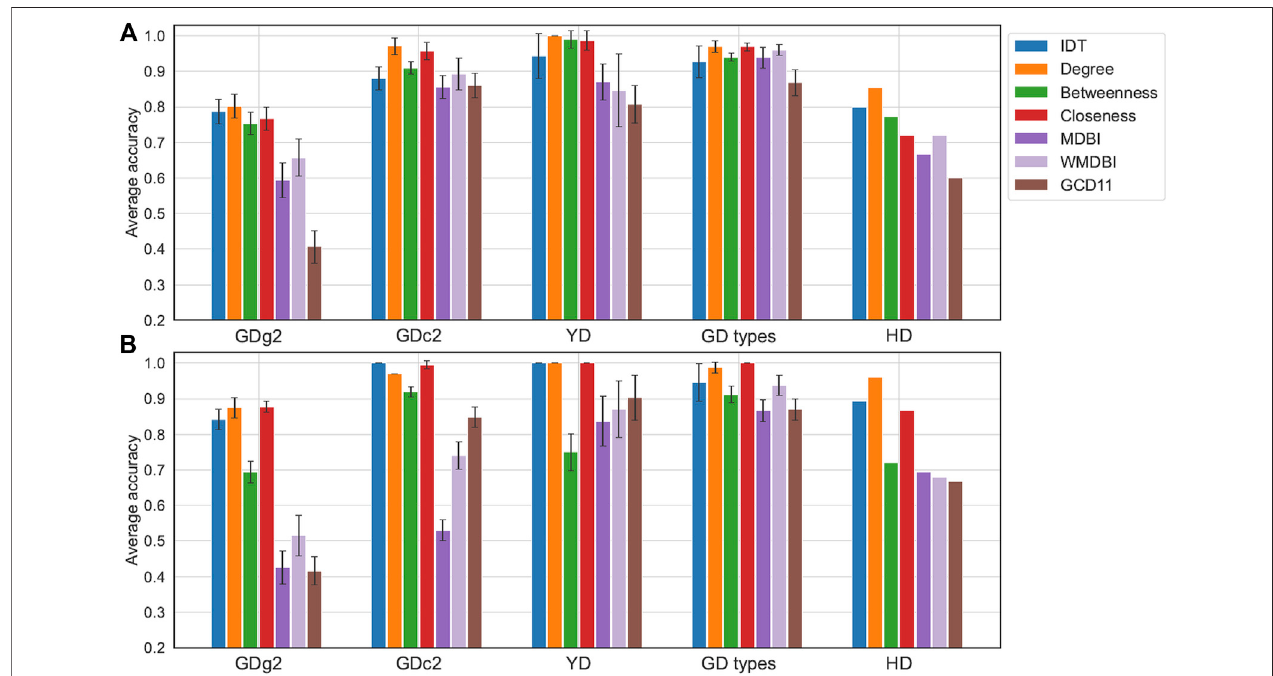
FIGURE 4 | Classi fi cation performance of models developed from IDT-treated data or sMDiN graph property methods. (A) Performance of random forest (RF) models; (B) performanceofprojectioninlatentstructures – discriminantanalysis(PLS-DA).Foralldatasetsexcept HD ,accuracywasestimatedby20iterationsofinternal three- or fi vefold strati fi ed cross-validation, with the error bars representing the accuracy standard deviation. For the HD dataset, accuracy was estimated on a test set resulting from a strati fi ed random 70/30% train/test split. Methods are as follows: intensity-based data pretreatment (IDT); network analysis: degree analysis (degree), betweenness centrality analysis (betweenness), closeness centrality analysis (closeness), MDB impact (MDBI), weighted MDB impact (WMDBI), and GCD-11 topology analysis (GCD11).